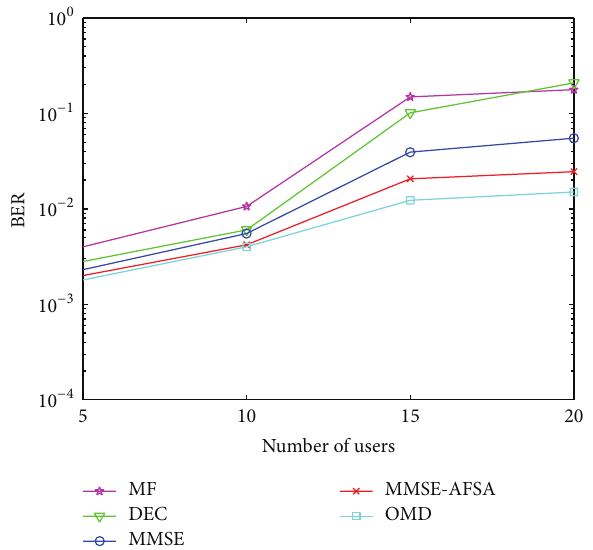
Figure 4: The BER performance versus user number 𝐾